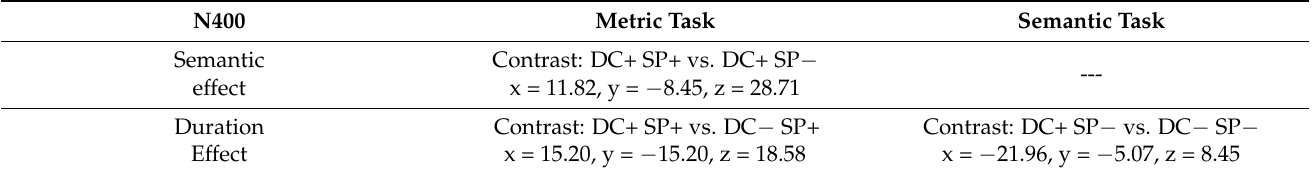
Table 4. Maximal statistical difference at Talairach coordinates for the significant contrasts detected in the early